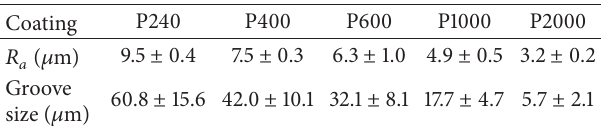
Table 1: Surface roughness and groove sizes of the microstructured coatings.